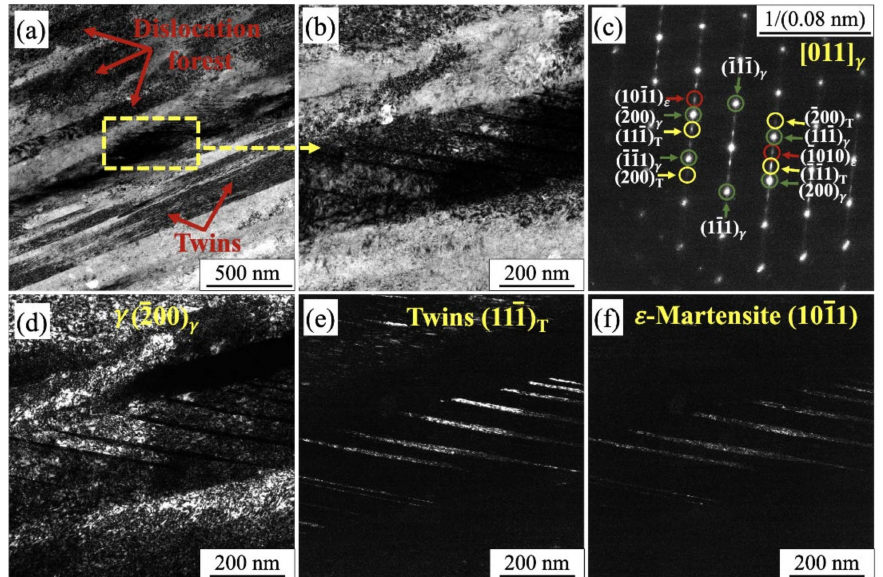
Figure 12. ( a ) Bright field TEM image of the microstructure adjacent to failure region; ( b ) magnified view of the selected location; ( c ) SAED pattern of the corresponding location; ( d – f ) dark field images of corresponding SAED